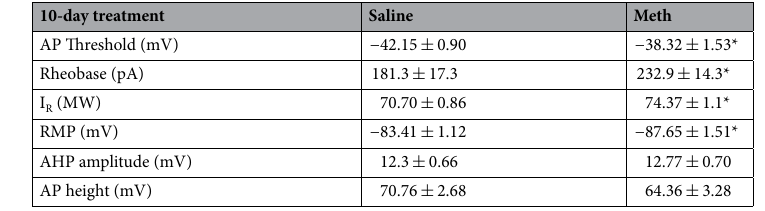
Table 2. DMS iSPN membrane properties: 21 days of abstinence. Data presented as mean ± s.e.m. and analyzed using unpaired t - or Mann–Whitney tests where appropriate; saline n = 15 neurons/5 mice; meth n = 17 neurons/7 mice; *p <